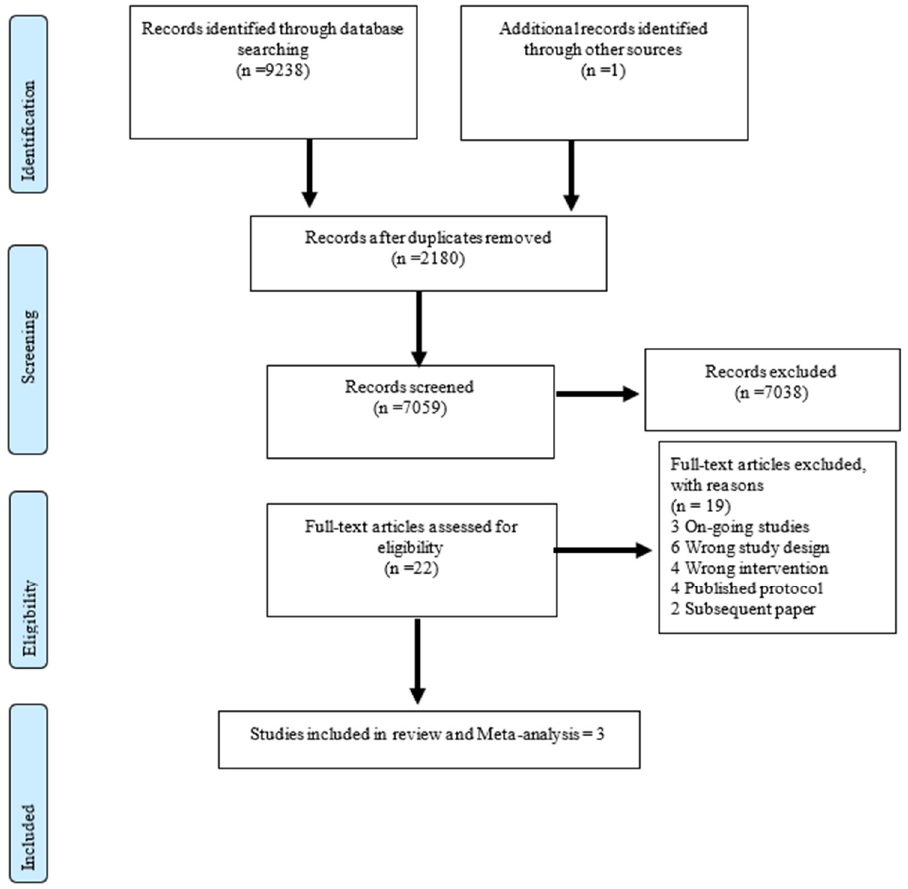
Figure 1. PRISMA flow chart indicating included and excluded studies and the overall reasons for exclusion in a systematic review of varying quantities and duration of RUTF for the treatment of severe wasting and/or oedema in children. Note: Reasons for the exclusion of studies are presented comprehensively in Supplementary Materials Table S4.